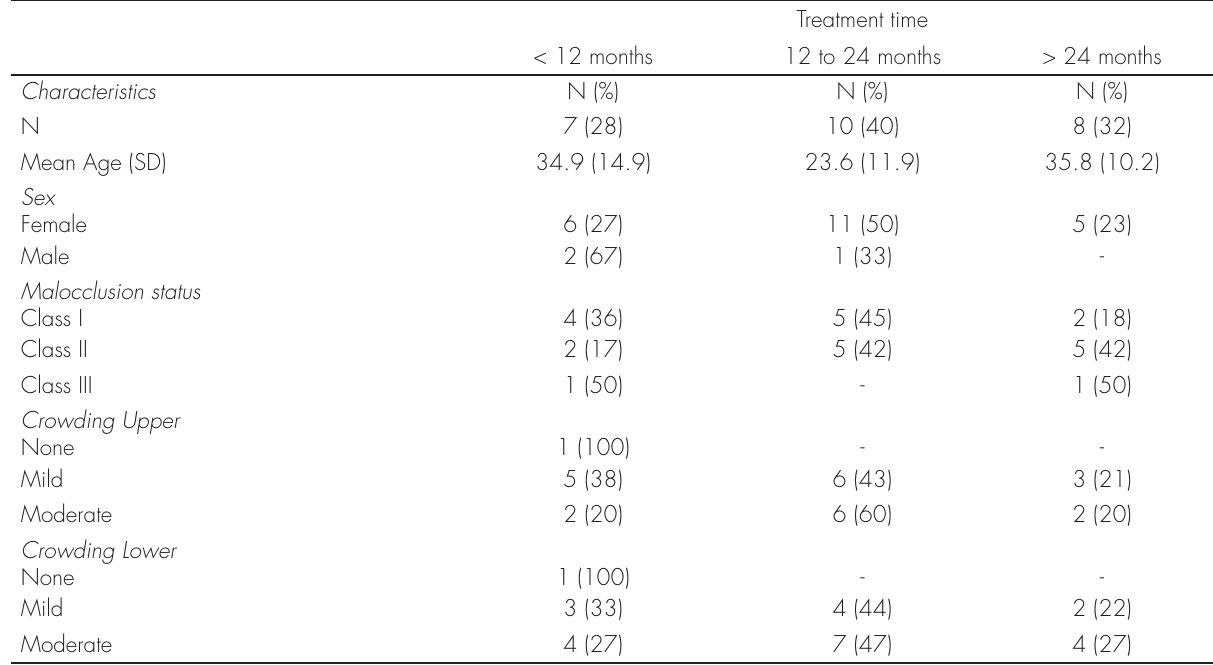
Table I. Frequency and percentages for sample characteristic